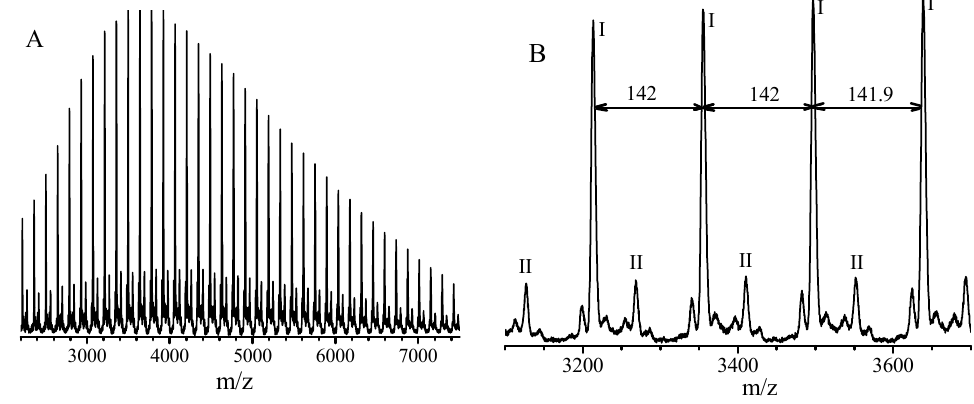
Figure 8. Matrix-assisted laser desorption ionization time-of-flight mass spectrometry (MALDI-TOF MS) spectrum ( A ) and enlarged spectrum ( B ) of the poly(glycidyl methacrylate) obtained by radical polymerization with feed molar ratio of GMA/TPPT/AIBN = 20/2/1 in anisole (concentration = 20 wt. %) at 70 °C for 24 h. Table 1. Conditions and results for the controlled radical polymerization of methacrylates in the presence of TPPT and AIBN in anisole (concentration: 50 wt %) a .